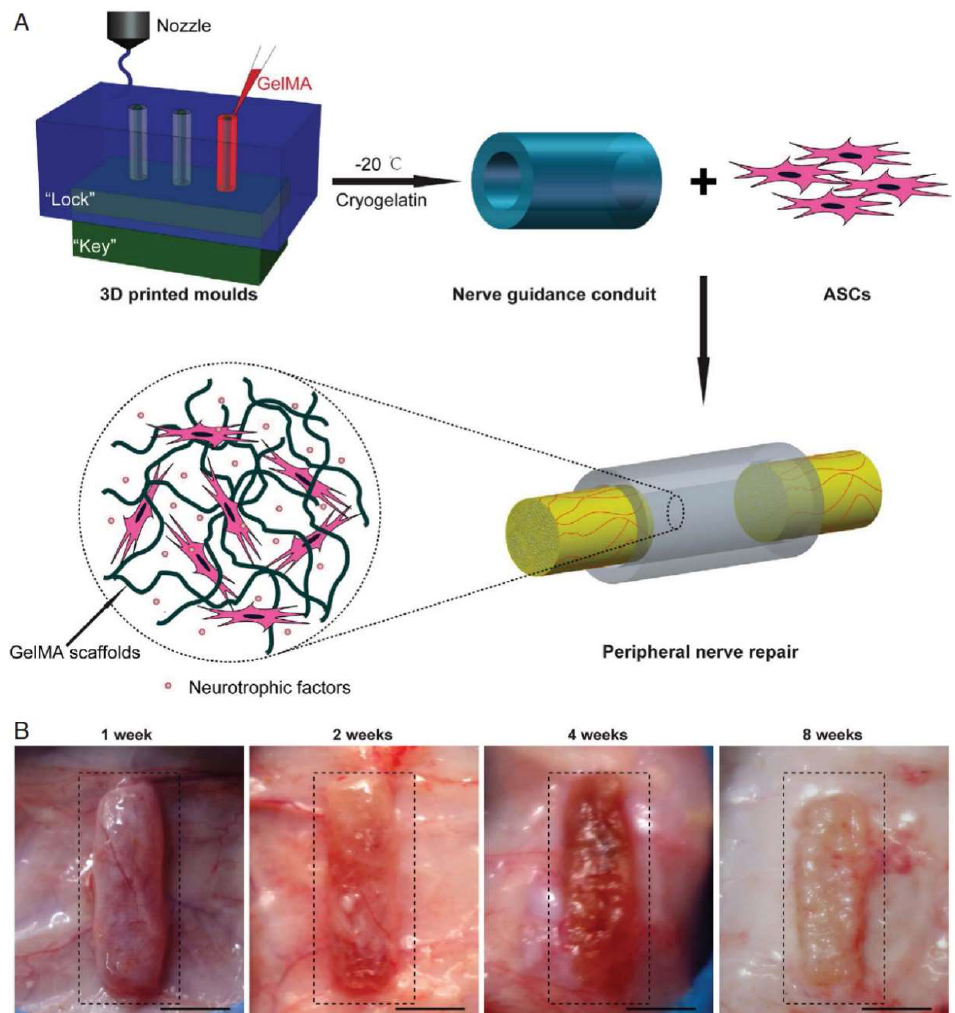
Figure 3. Cellularized conduits for peripheral nerve regeneration created using 3D printed molds. ( A )